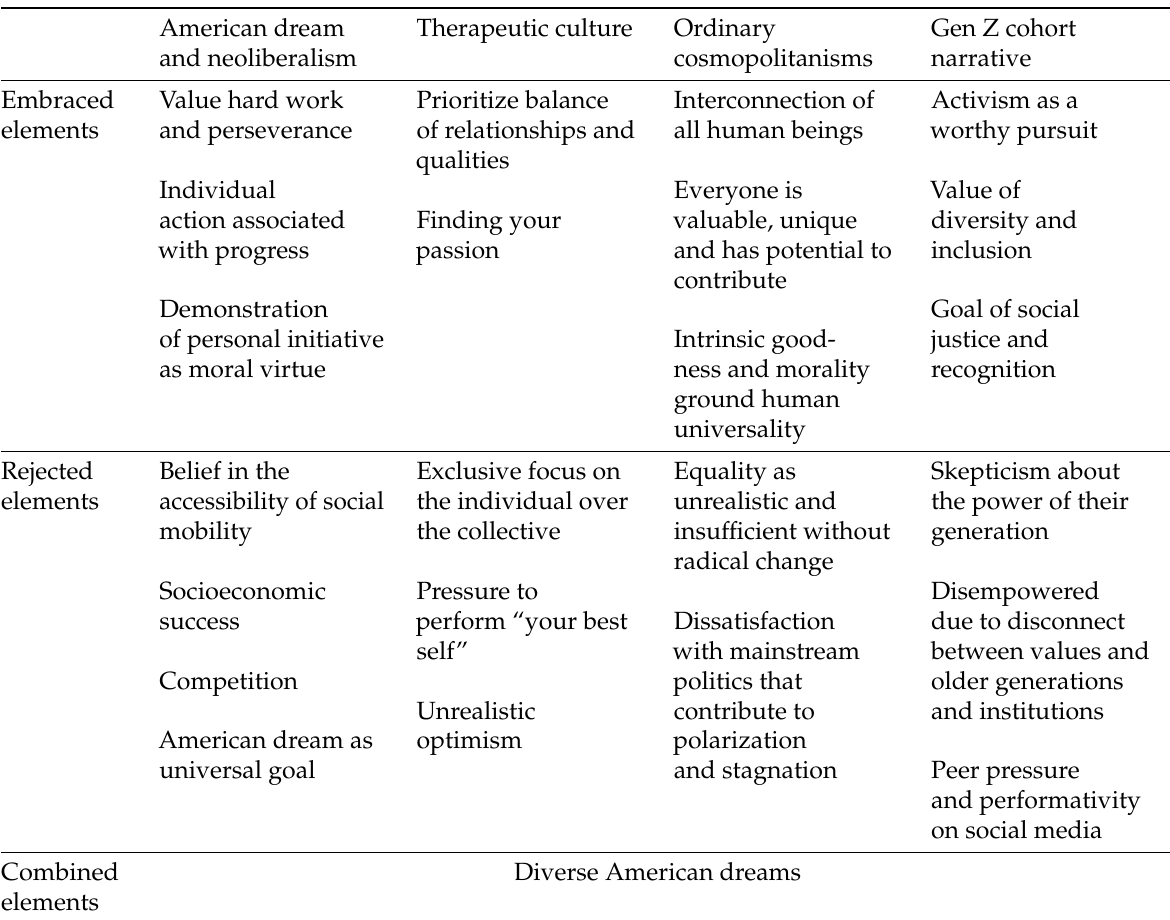
Figure 2: Embraced, rejected, and combined cultural